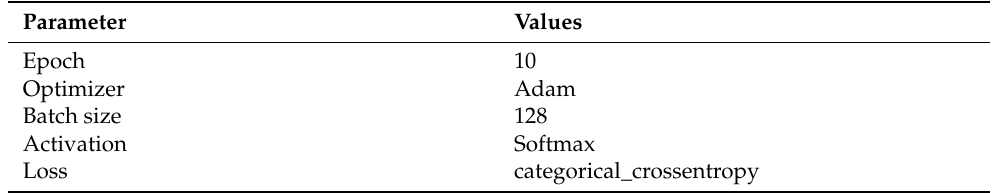
Table 4. Parameter setting of